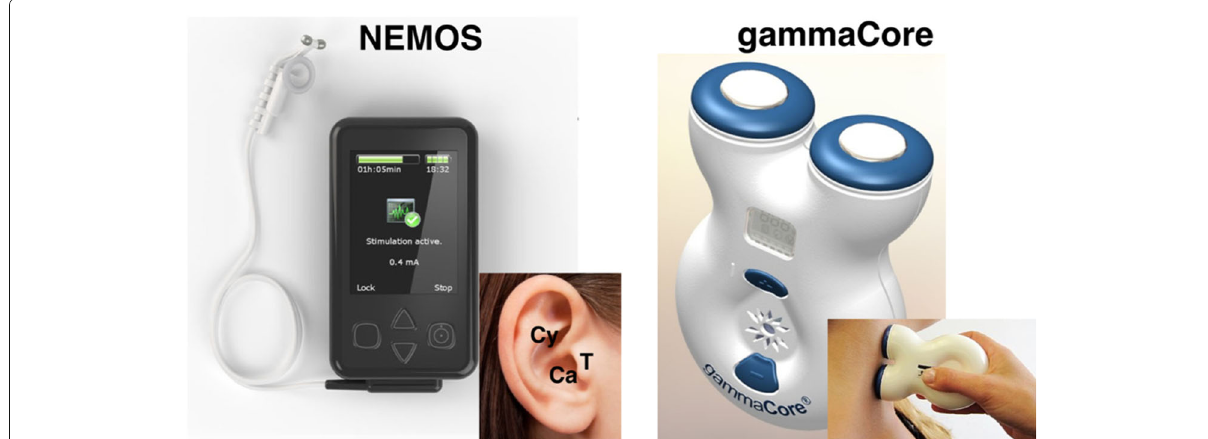
Fig. 3 Two non-invasive VNS devices. NEMOS is a transauricular VNS device that stimulates the cymba chonca. GammaCore is a transcervical, self-administered VNS device stimulating through the neck to the cervical VN (Yuan and Silberstein